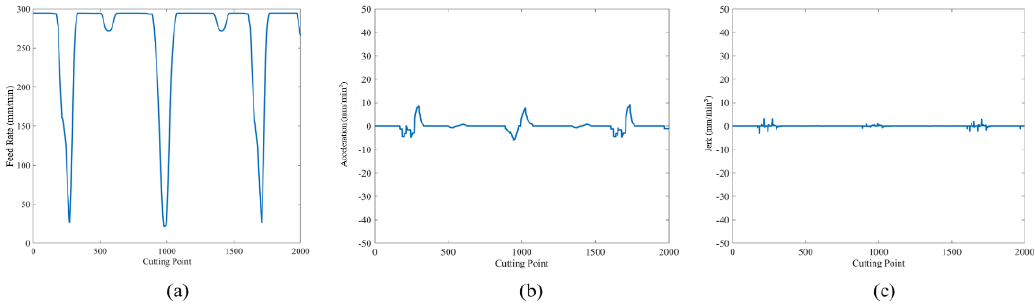
Figure 22. Cutting trident shape using our method with maximum feed rate of 300 mm/min: ( a ) feed rate, ( b ) acceleration, and ( c ) jerk. Table 8. Tracking error and processing time for trident shape.